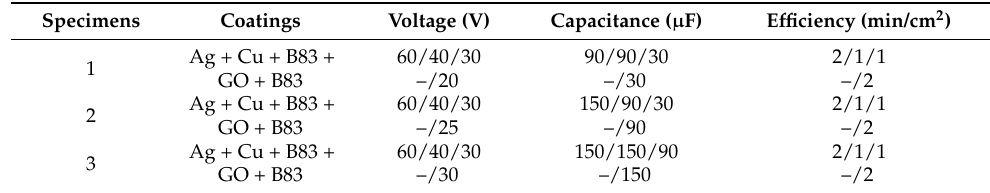
Table 1. The electro-spark deposition parameters of the running-in coatings.